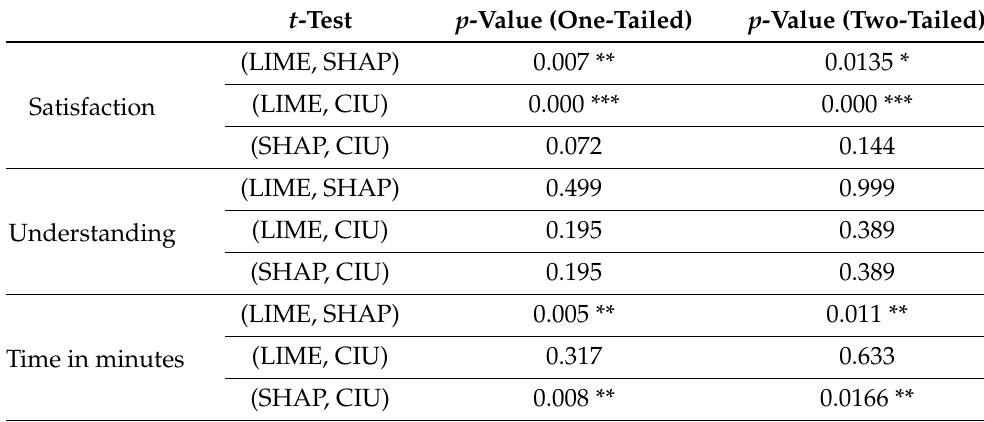
Table 13. t -tests: Satisfaction, understanding and time spent (note: * p < 0.05, ** p < 0.01, *** p <